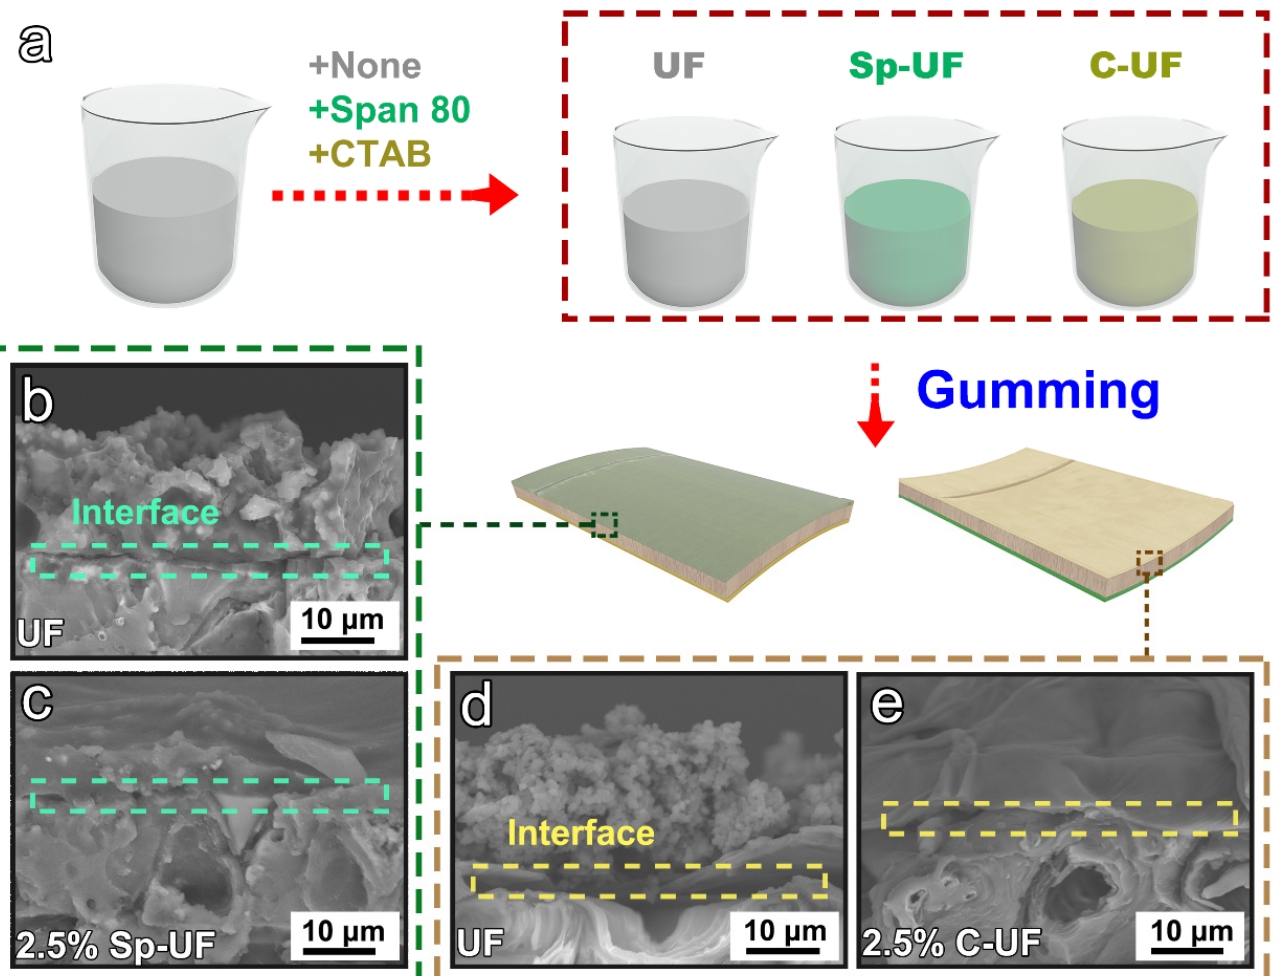
Figure 5. ( a ) Schematic procedure of the fabrication process. SEM images of ( b ) cured UF resin coated on the bamboo green, ( c ) cured 2.5% Sp-UF resin coated on the bamboo green, ( d ) cured UF resin coated on the bamboo yellow, and ( e ) 2.5% C-UF resin coated on the bamboo yellow.